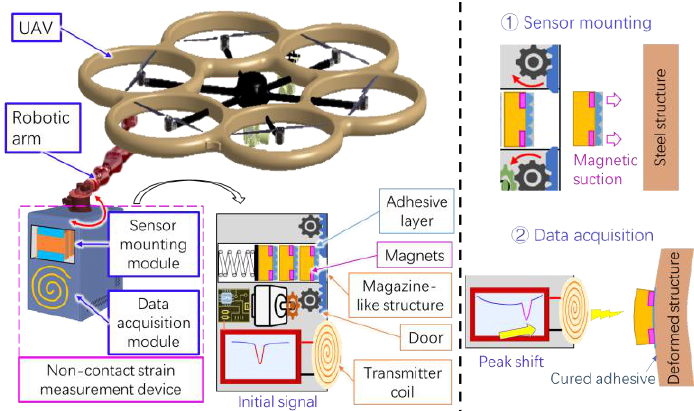
Figure 12. The concepts of non-contact sensor mounting and data acquisition. The strain measure- ment device is connected to a robotic arm integrated into a UAV. The module includes two modules: sensor mounting module and data acquisition module.